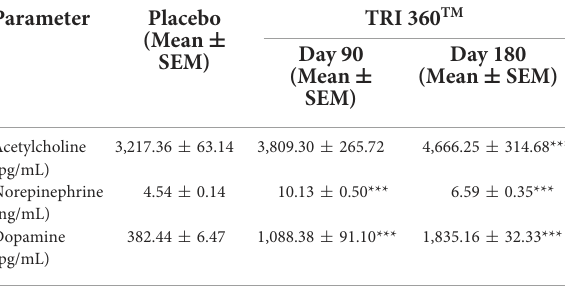
TABLE 4 Measurement of neurotransmitters (acetylcholine, noradrenaline, and dopamine) in serum after treatment with the TRI 360 TM in human subjects, measured at days 90 and 180.